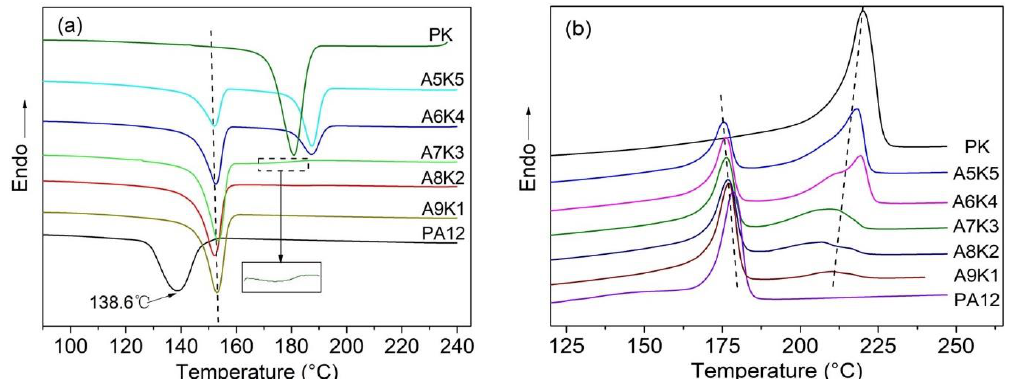
Figure 6. Differential scanning calorimeter (DSC) curves for PA12, PK and the blends. ( a ) Cooling curves (cooling rate: 10 ◦ C/min). The insert shows a magnified fragment of curve for A7K3. ( b ) 2nd heating curves (heating rate: 10 ◦ C/min). Table 2. Crystallization parameters of PA12, PK and the blends determined from Figure 6a.